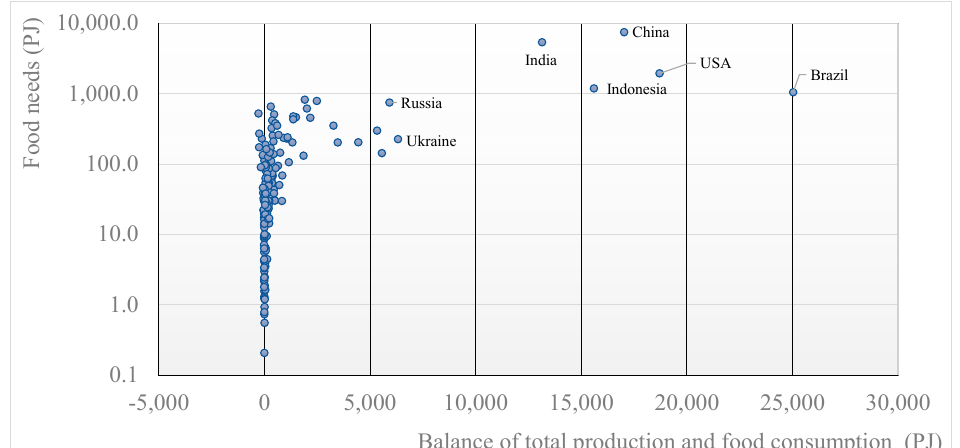
Figure 1. Balance of food vs. the food needs.